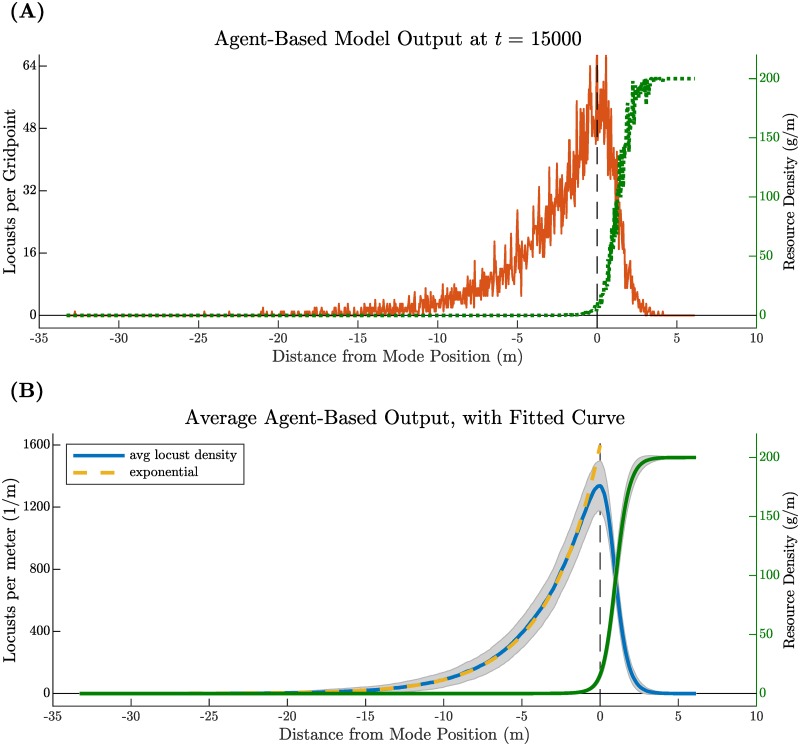
Output of the agent-based model with N = 7000 locust agents at time t = 15000 sec, re-centered so that the mean position of all locusts occurs at zero.(A) Shows the final state of the model including the number of locusts at each spatial grid point (orange) and the remaining resource density at each spatial grid point (dotted, green). Compares well with previously published data, see Figure 1 in [9]. (B) Displays a time-average of model outputs taken after an amount of time to account for transients (in this case, approximately t = 7500). Gray shading indicates ± one standard deviation from the average locust density (blue) and resources (green). The tail of the pulse agrees well with an exponential least squares fit (gold). S1 Video shows a full, time-dependent simulation of the ABM.